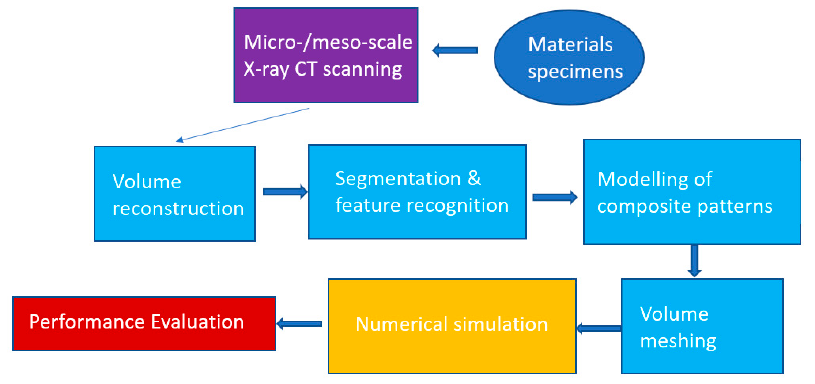
Figure 1. Flowchart of our approach.